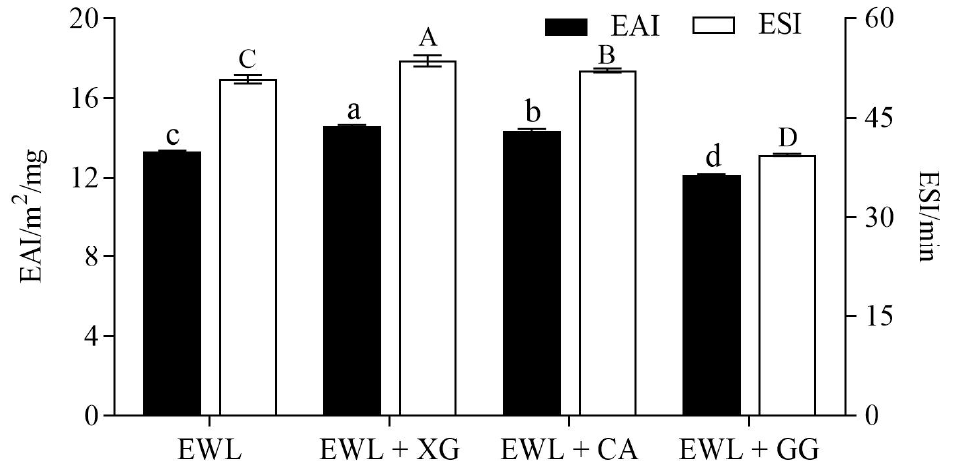
Figure 3. Effects of polysaccharide added to egg white liquid on EAI and ESI. Different lowercase letters indicate a significant difference ( p < 0.05) between EAI groups, and different uppercase letters indicate a significant difference ( p < 0.05) between ESI groups.